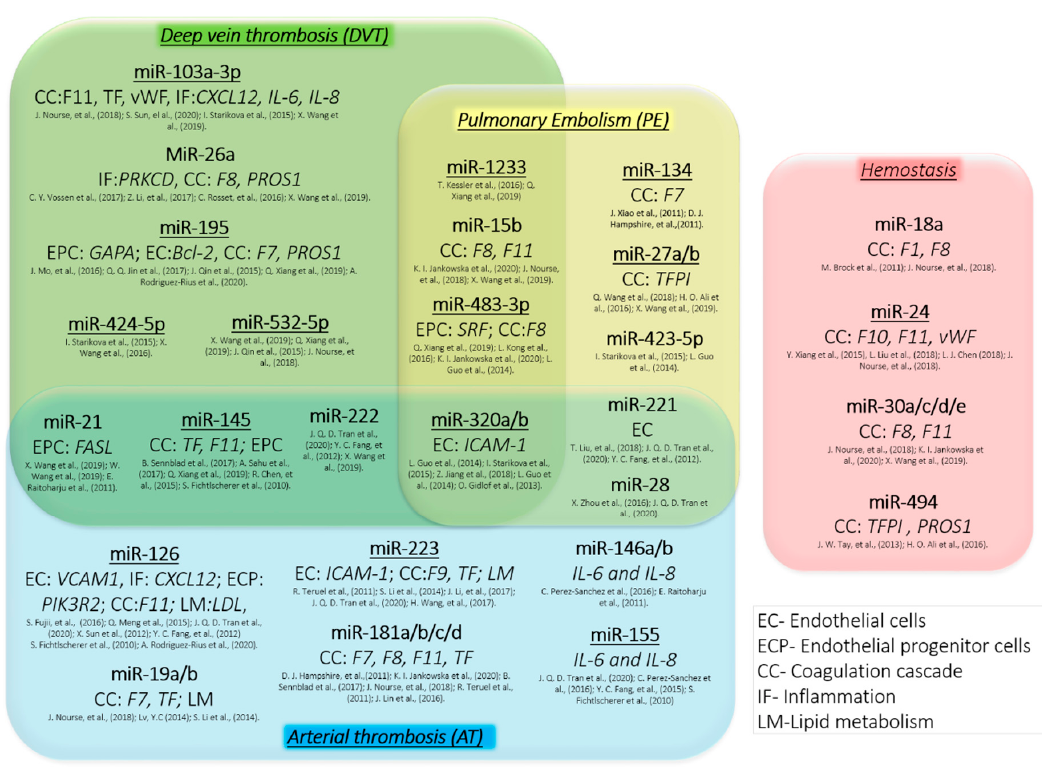
Figure 1. Role of miRNAs in thrombosis and hemostasis. The association of some miRNAs with different types of thrombosis and hemostasis along with the potential target genes (in italic) of proteins essential for coagulation cascade (CC), endothelial progenitor cell (EPC) or endothelial cell (EC) regulation, inflammation (IF) and lipid metabolism (LM). Selected miRNAs have been reported to play an important role in regulation of hemostasis in multiple independent research studies and thus are promising biomarkers (underlined) and therapeutic targets for the treatment of thrombosis and bleeding disorders.